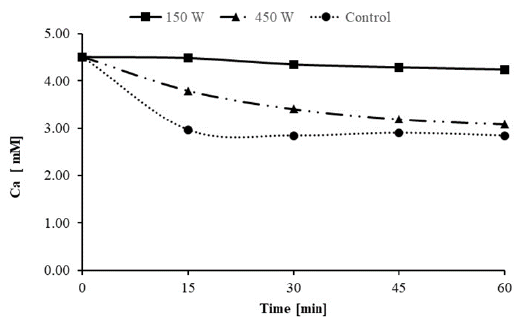
Figure 2. Comparison of pH variation with and without ultrasound treatment.